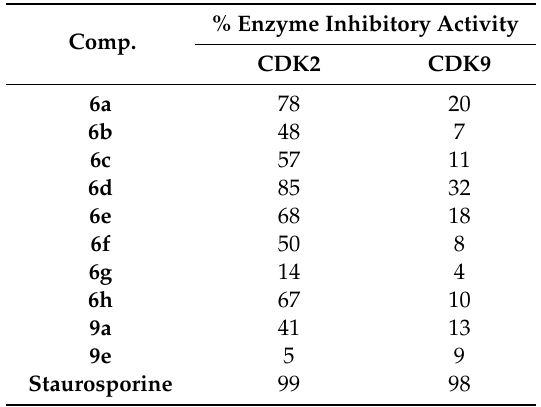
Table 6. Inhibitory e ff ect of compounds 6a–h , 9a , and 9e on CDK2 and CDK9 at a single-dose of 20 µ M.